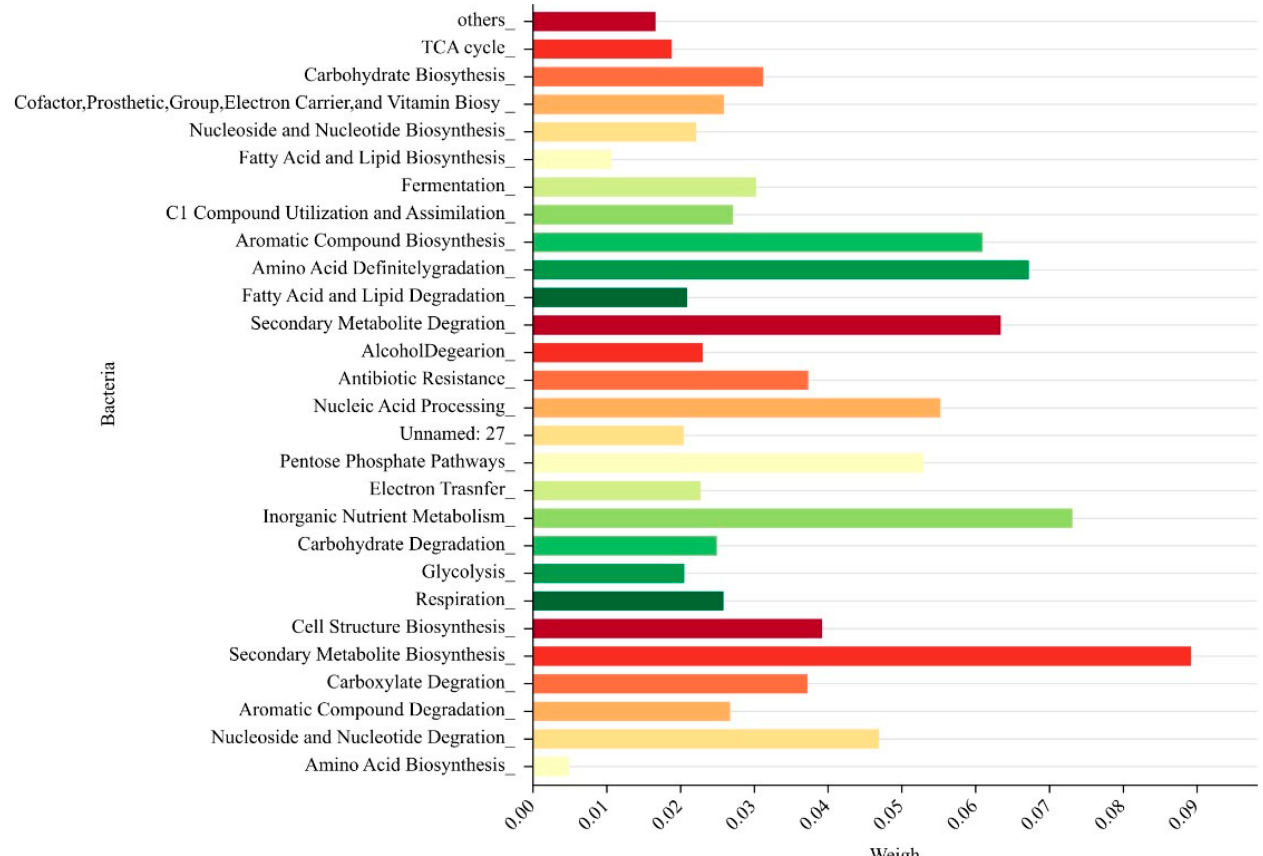
Figure 14. Histogram of importance of each bacterium. Secondary Metabolite Biosynthesis has the highest weight; Amino Acid Biosynthesis has the lowest weight.